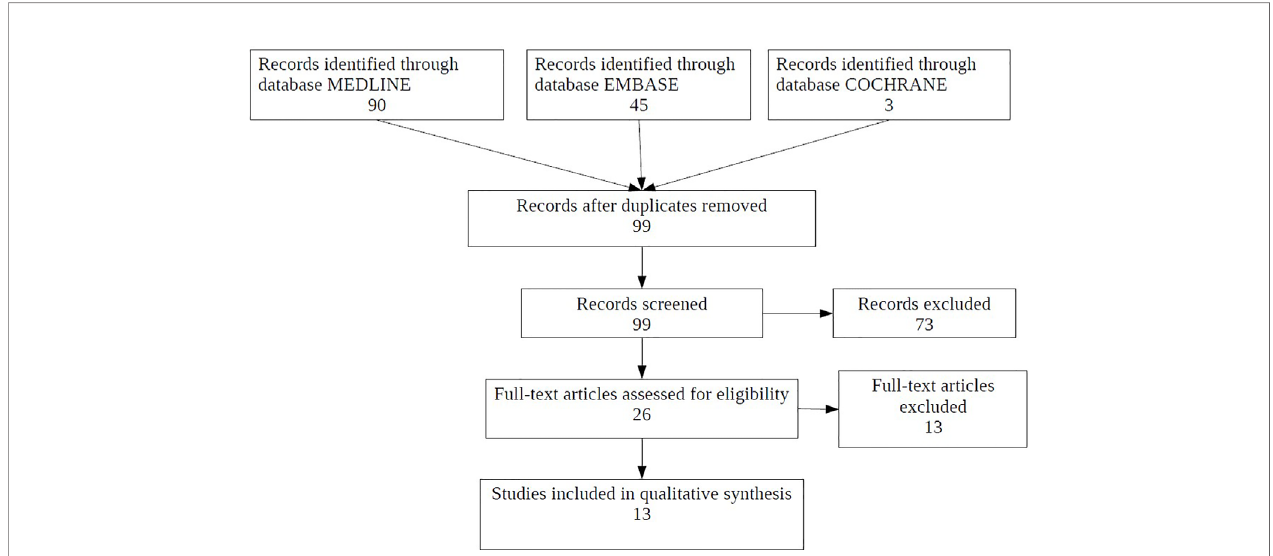
FIGURE 1 | Flow diagram of included